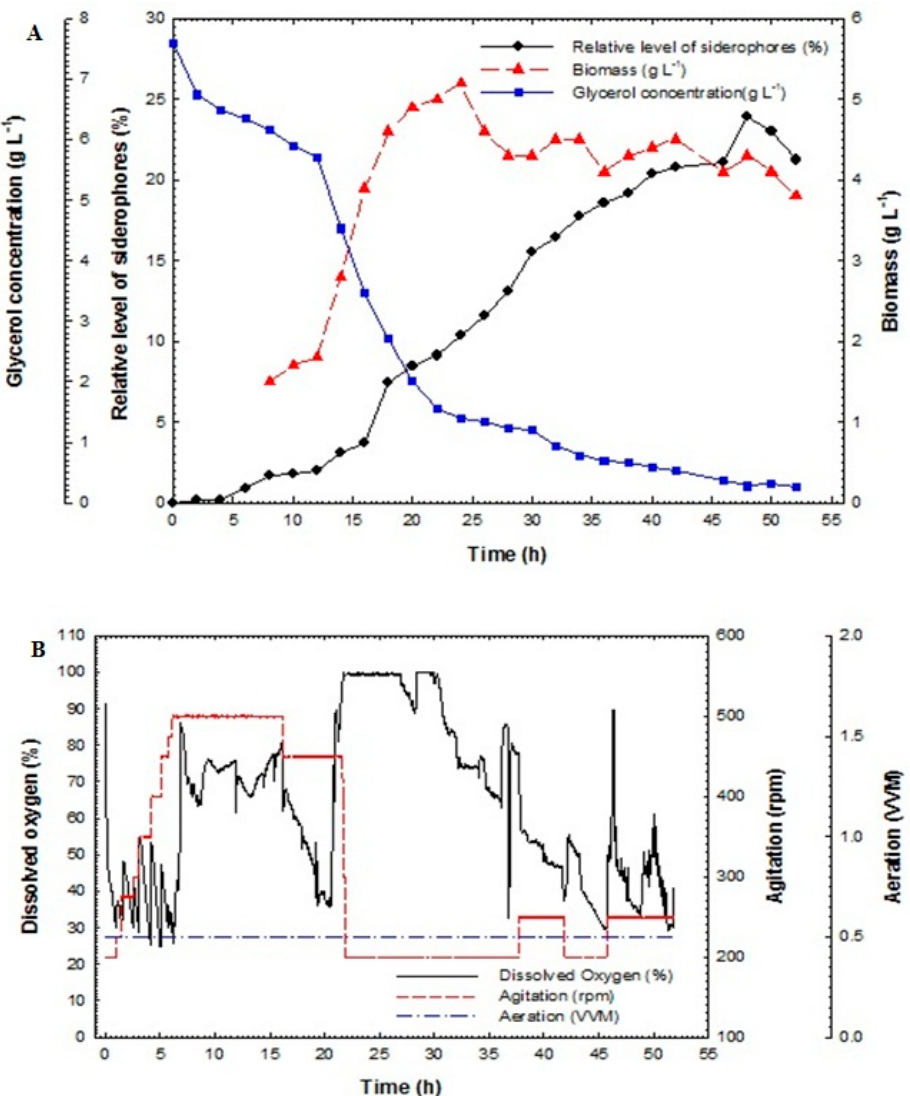
Figure 4. ( A ) Relative level of siderophores, biomass and glycerol concentration as a function of